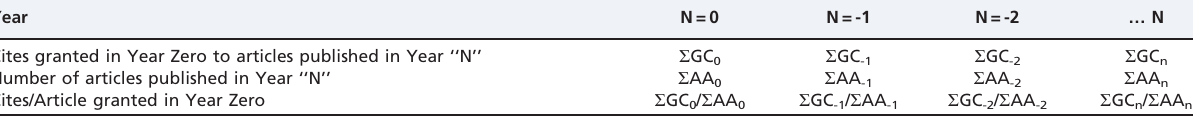
Table 1 - A modified version of half-life tables from ISI Journal Citations